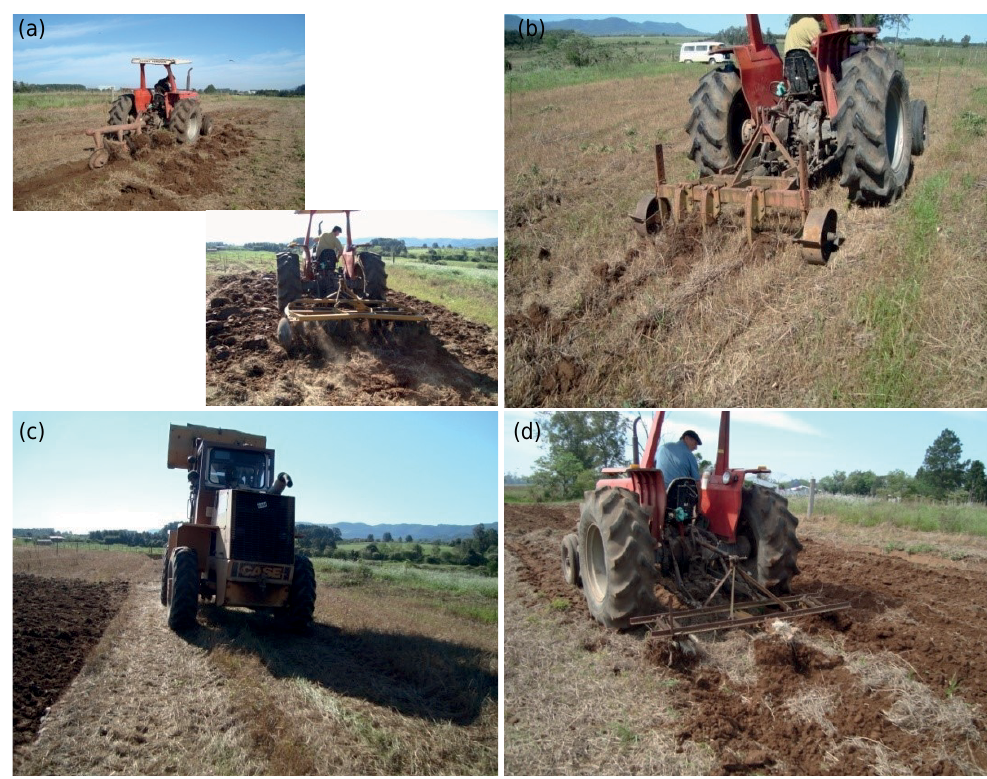
Figure 1. Soil tillage for cassava planting: (a) conventional tillage (plowing and harrowing), (b) chisel plowing, (c) compacting no-till soil, and (d) opening of furrows for cassava